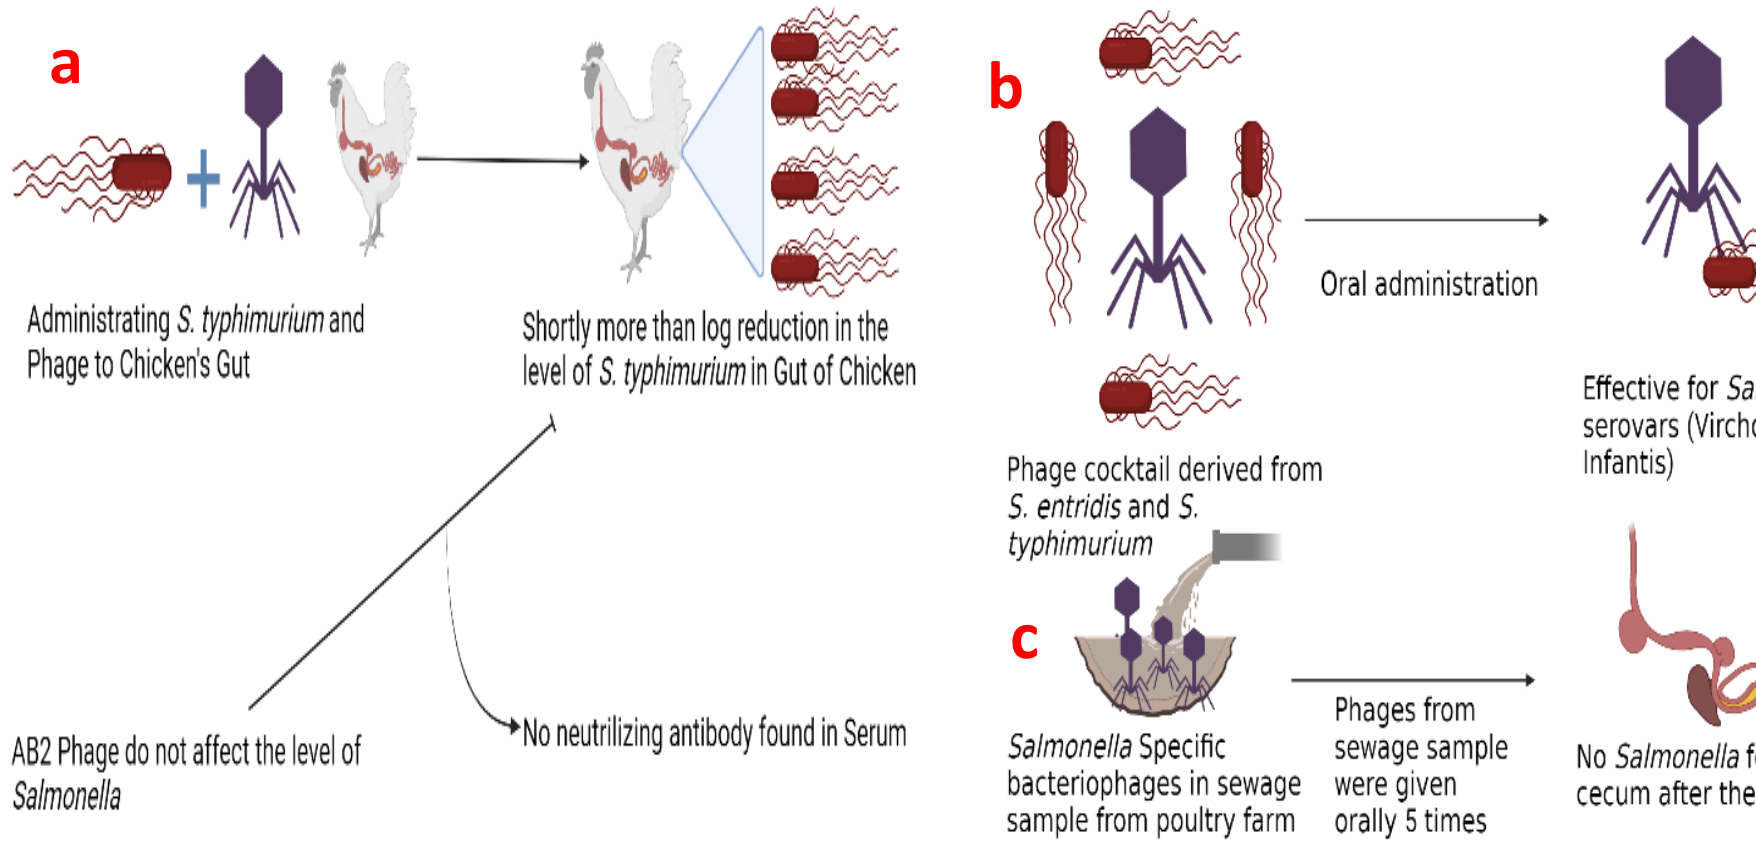
Figure 2. Shows how phages work against Salmonella . ( a ) delivering S. typhimurium and phages to the gut of the chicken. In no time, the level of S. typhimurium will reduce by Log 10. While AB2 phages do not have any impact on the level of salmonella, thus no neutralizing antibodies are found in the serum. ( b ) Oral administration of phage cocktails derived from S. enteritidis, and S. typhimurium will be effective for salmonella serovars (Virchow, Hadar, Infentis). ( c ) Salmonella - specific bacteriophages in a sewage sample from a poultry farm given orally 5 times. As a result, no salmonella was found in the serum.